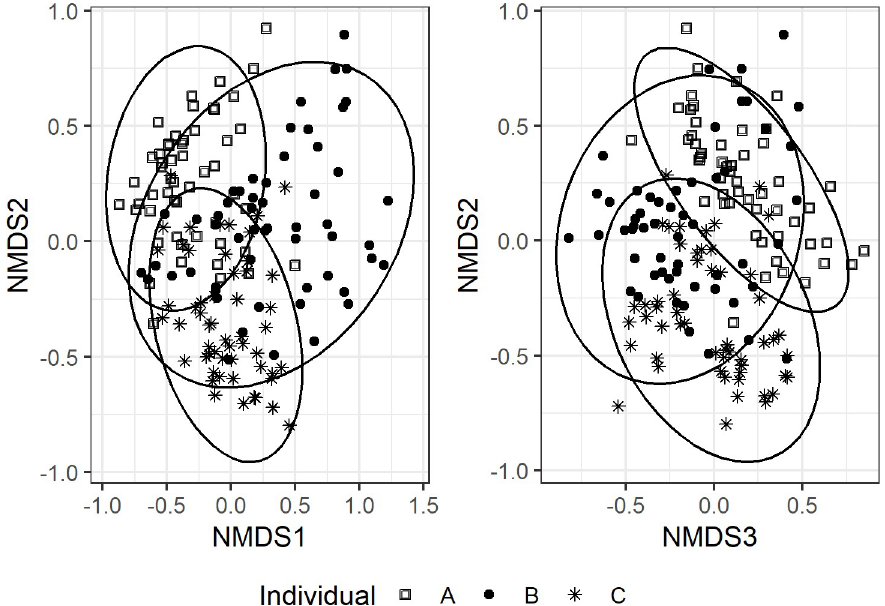
Fig 4. Non-metric multidimensional scaling (NMDS) ordination performed on Bray-Curtis dissimilarities of bone bacterial communities (n = 162) and visualized by individual. Stress = 0.14 and k = 3; ellipses represent 95% confidence